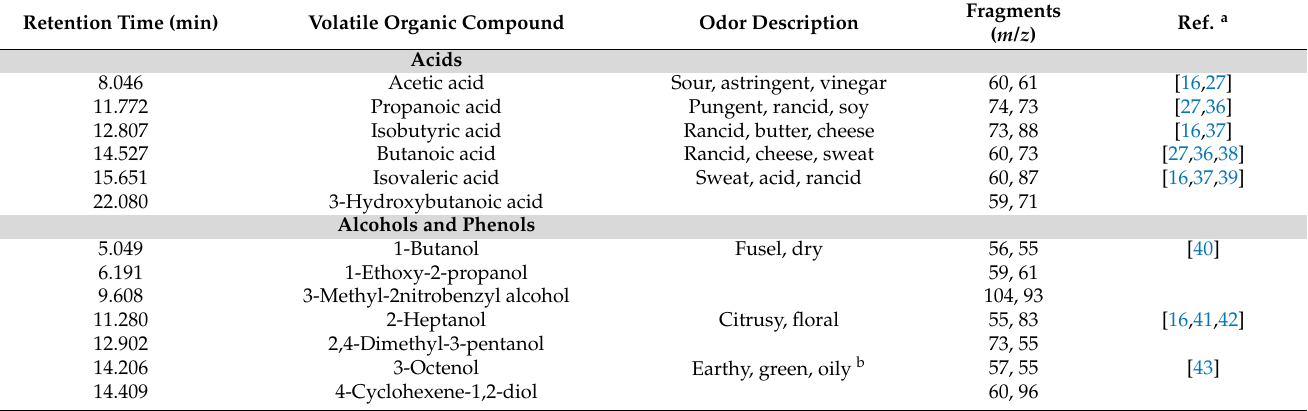
Table 1. Volatile compounds of dark chocolate from northern Peru